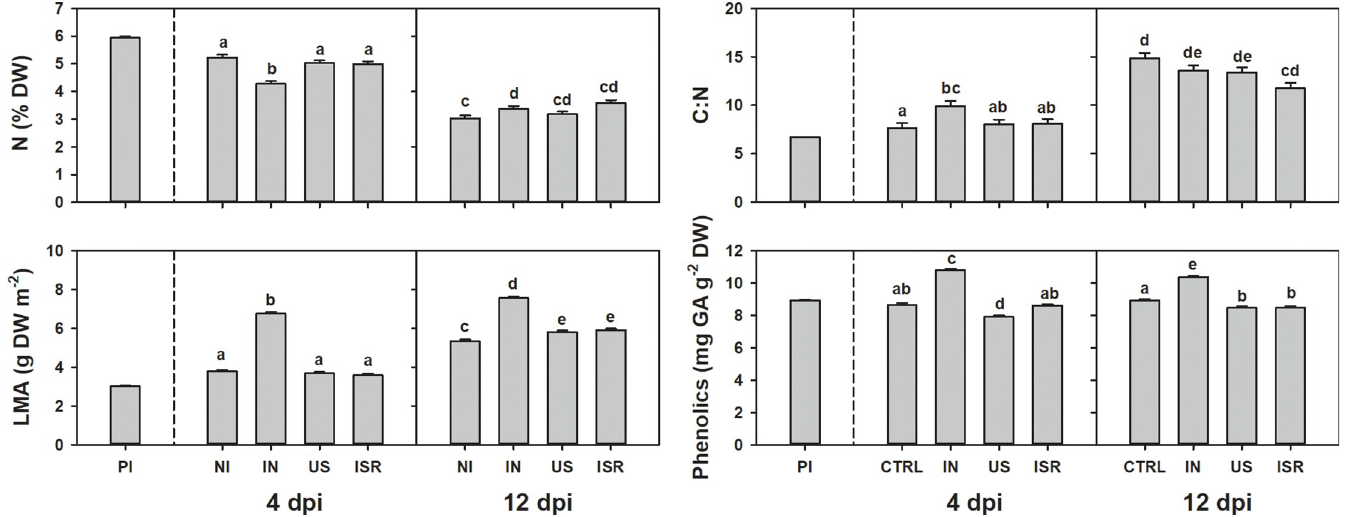
Fig 3. Mean ± SD of nitrogen (N), ratio of carbon to nitrogen (C:N), leaf mass per area (LMA) and phenolics at pre infestation (PI) and at four and twelve days post infestation (dpi) for the non-infested (NI) control, and plants with incompatible (IN) and compatible (H13-US, US; H13-ISR, ISR) populations. Statistical analysis includes only NI, IN, US, ISR. DW, dry weight. Treatments not connected by the same letter are significantly different ( p > 0.05).